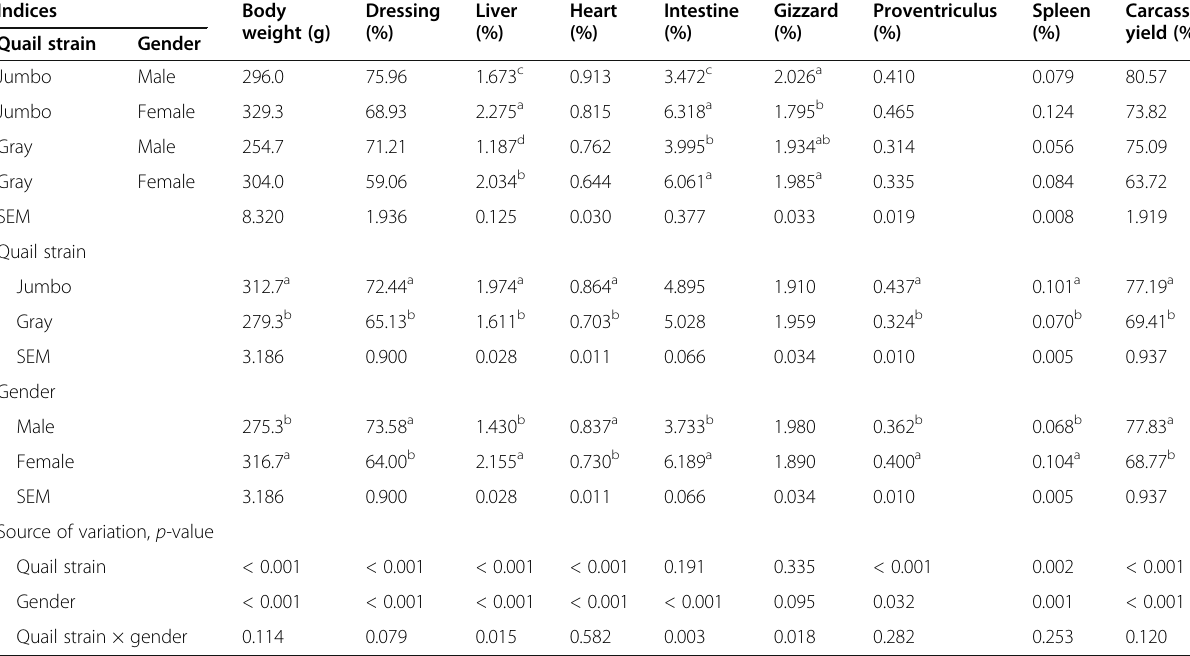
Table 3 Differences between jumbo and gray Japanese quail strains in marketing body weight and carcass characteristics